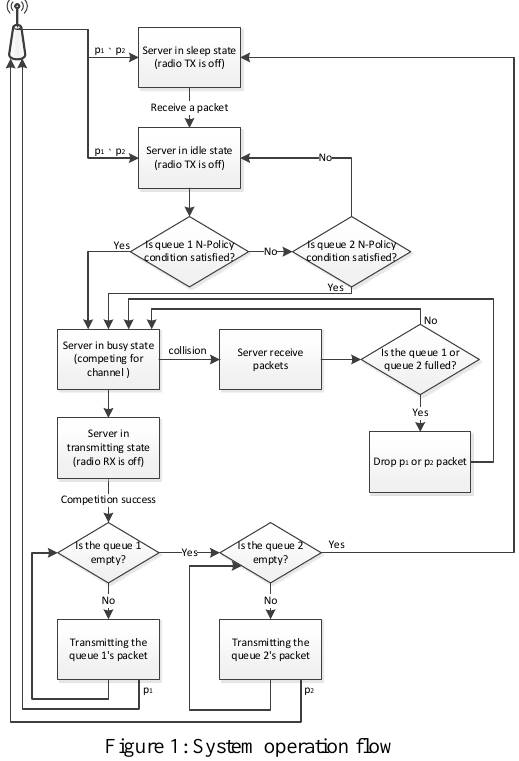
Figure 1: System operation